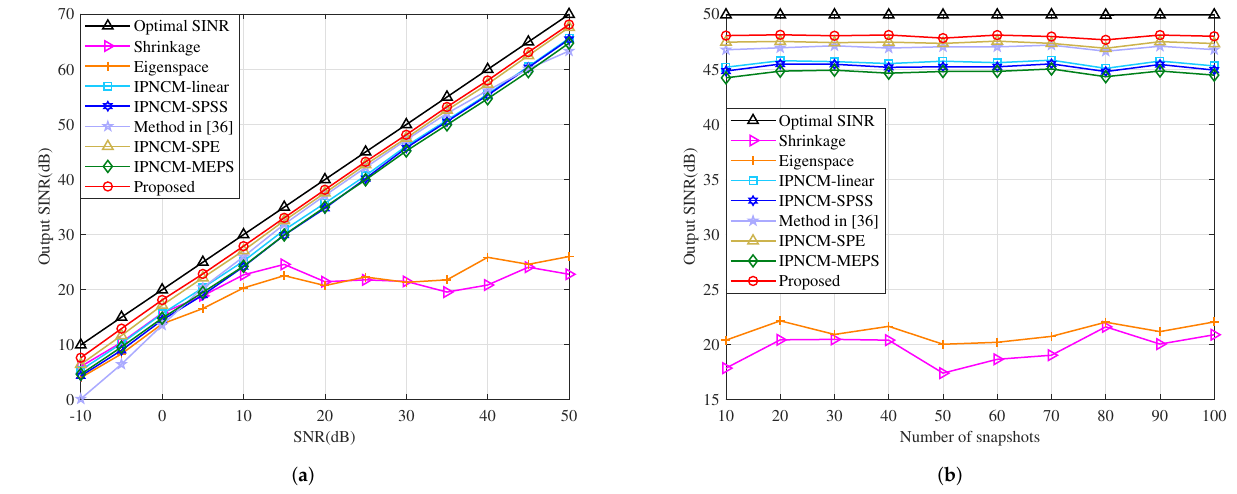
Figure 13. Output SINR in the case of incoherent local scattering versus ( a ) input SNR, JNR = 30 dB, K = 50. ( b ) the number of snapshots, SNR = 30 dB, JNR = 30